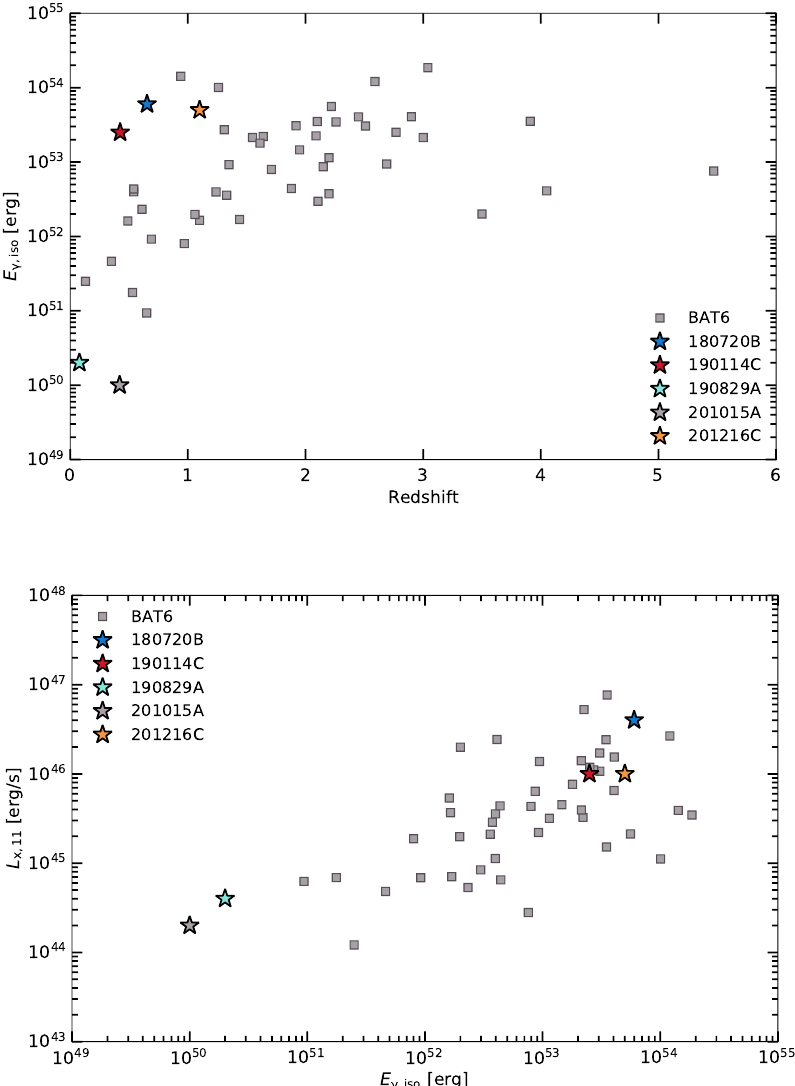
Figure 8. GRBs detected at VHE compared to GRBs from the complete sample BAT6. Top : isotropic equivalent energy E γ ,iso emitted in the prompt phase versus redshift. Bottom : X-ray afterglow luminosity (2–10keV, rest frame) at 11h (rest frame) versus E γ ,iso